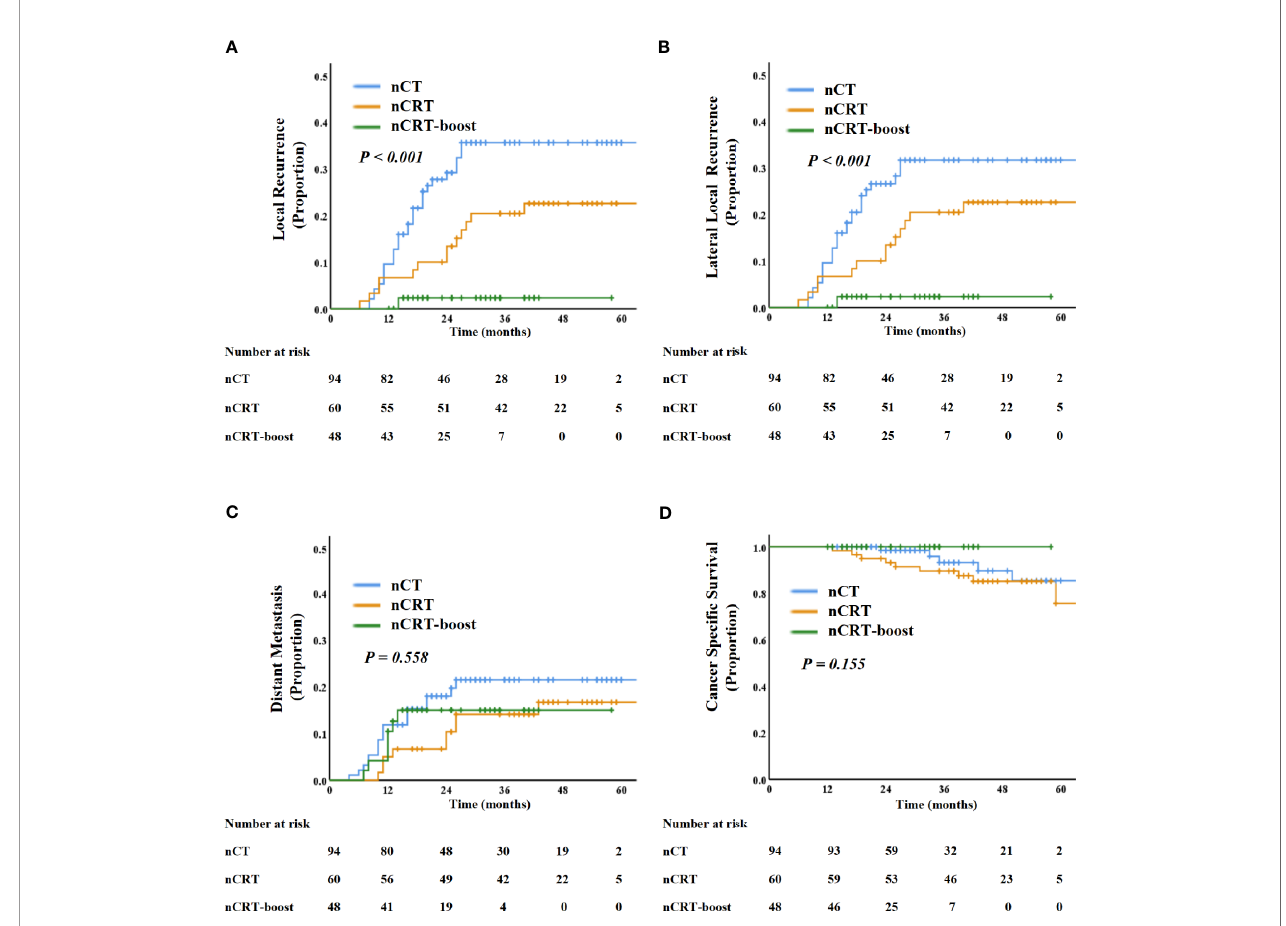
FIGURE 2 | Kaplan – Meier curve analysis of local recurrence (A) , lateral local recurrence (B) , distant recurrence (C) , and cancer-speci fi c survival (D) comparing the patients with LLNs metastasis underwent three different treatment regimens: nCT, nCRT, and nCRT-boost